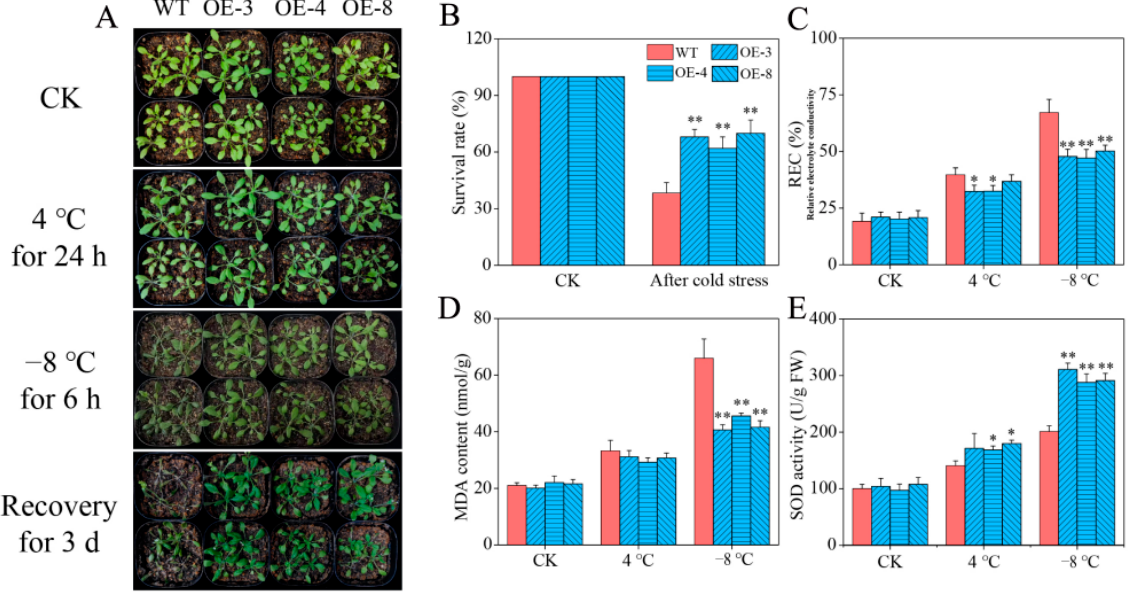
Figure 6. Effect of CaSPDS overexpression on Arabidopsis tolerance to cold stress. ( A ) Phenotype, ( B ) survival rate, ( C ) relative electrolytic leakage, ( D ) MDA content, and ( E ) SOD activity of WT and transgenic lines after cold stress. “*” represents p < 0.05, and “**” represents p < 0.01 between WT and transgenic lines.